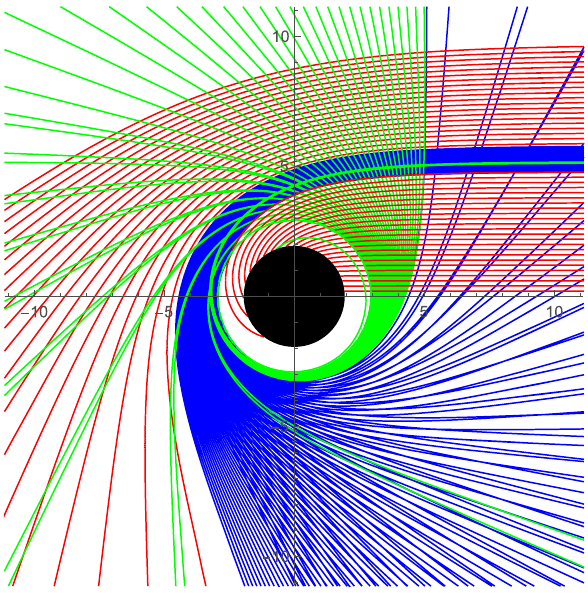
Fig. 9 The behavior of light rays as a function of the impact parame- ter b . We treat ( r ,φ) as the Euclidean polar coordinates. The red lines, blue lines and green lines correspond to the direct, lensed, and pho- ton ring trajectories, respectively. The spacing in impact parameter is 1 / 5 , 1 / 100 , 1 / 1000 in the direct, lensed, and photon ring bands. The black hole is shown as a solid disk and the photon orbit as a dashed line. We set α = − 5 . 5, M =